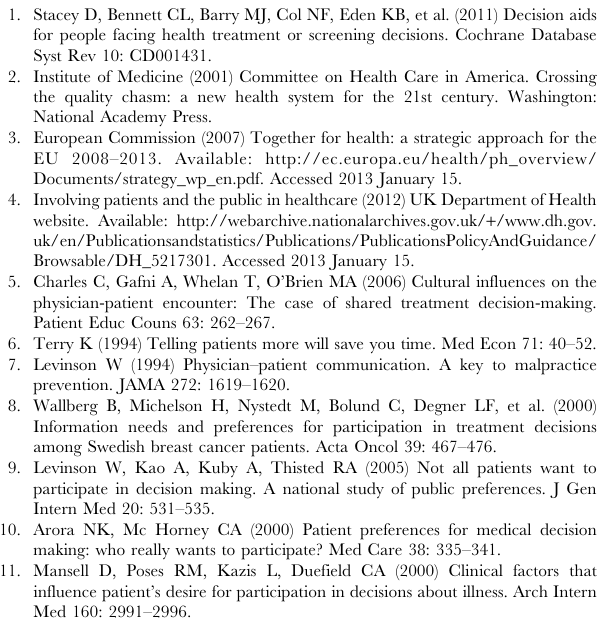
Figure S1 New CPS cards for use in male health